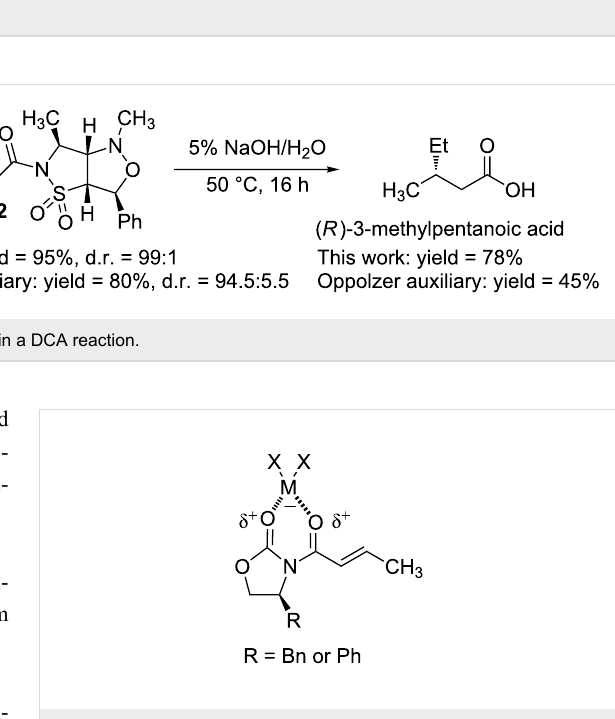
Figure 2: Chiral auxiliaries used in DCA reactions.